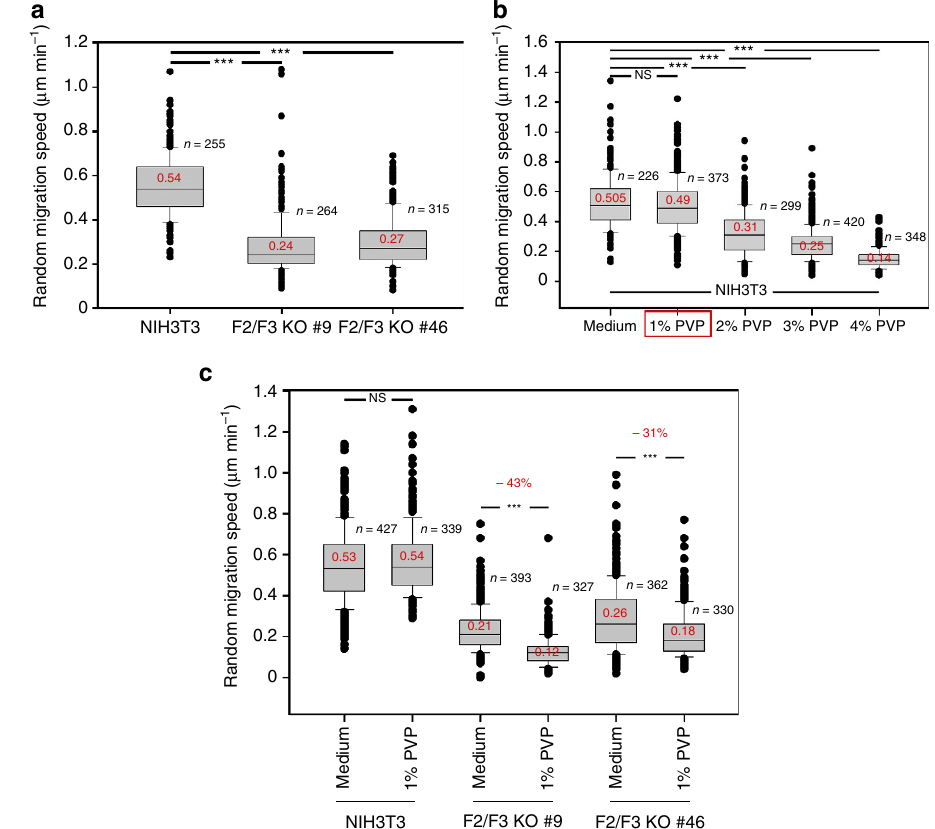
Figure 7 | Depletion of FMNL2/3 in fibroblasts recapitulates migration defects. ( a ) Box and whiskers plots summarizing quantification of random migration rates ( m m min (cid:2) 1 ) of double-knockout clones and wild-type NIH 3T3 cells as indicated. ( b ) Quantification of random migration speed ( m m min (cid:2) 1 ) of NIH 3T3 cells that were either migrating in regular medium or medium supplemented with different concentrations of polyvinylpyrrolidone (PVP) as indicated in the figure. Increase of PVP concentrations linearly correlates with decreased rates of random migration. As 1% PVP did not significantly affect migration of wild-type NIH 3T3 fibroblasts, this concentration was chosen for comparison with FMNL2/3 KO clones (red rectangle). ( c ) Box and whiskers plots summarizing quantification of random migration rates ( m m min (cid:2) 1 ) of double-knockout cell clones #9 and #46 as well as wild-type NIH 3T3 determined in regular medium versus medium of slightly increased viscosity (1% PVP), as indicated. Note the differential effect observed in medium of slightly increased viscosity (1% PVP) in KO clones versus wild-type cells (reduction of migration by 43% caused by 1% PVP in case of F2/F3 KO #9 and by 31% in case of F2/F3 KO #46). *** p o 0.001 by Mann–Whitney rank sum test.